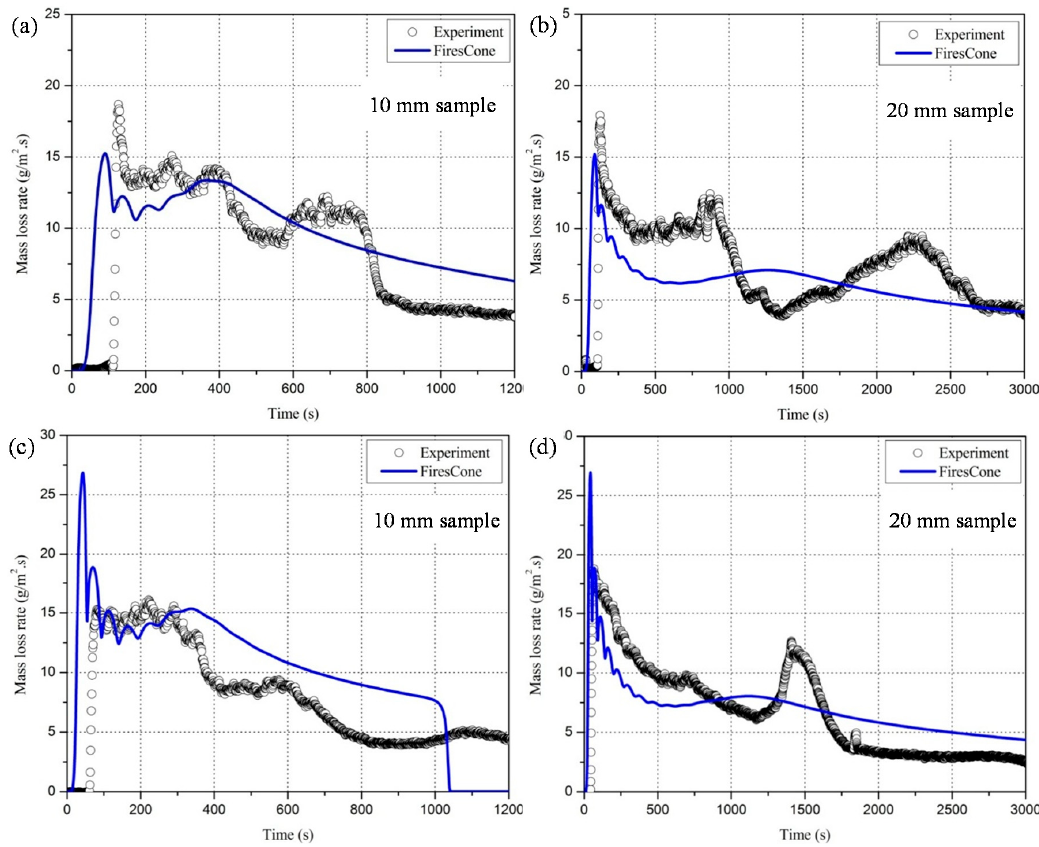
Figure 7. The comparison between modeling and experimental curves for PC under heat fluxes of: ( a , b ) 50 kW/m 2 ; and ( c , d ) 75 kW/m 2 .